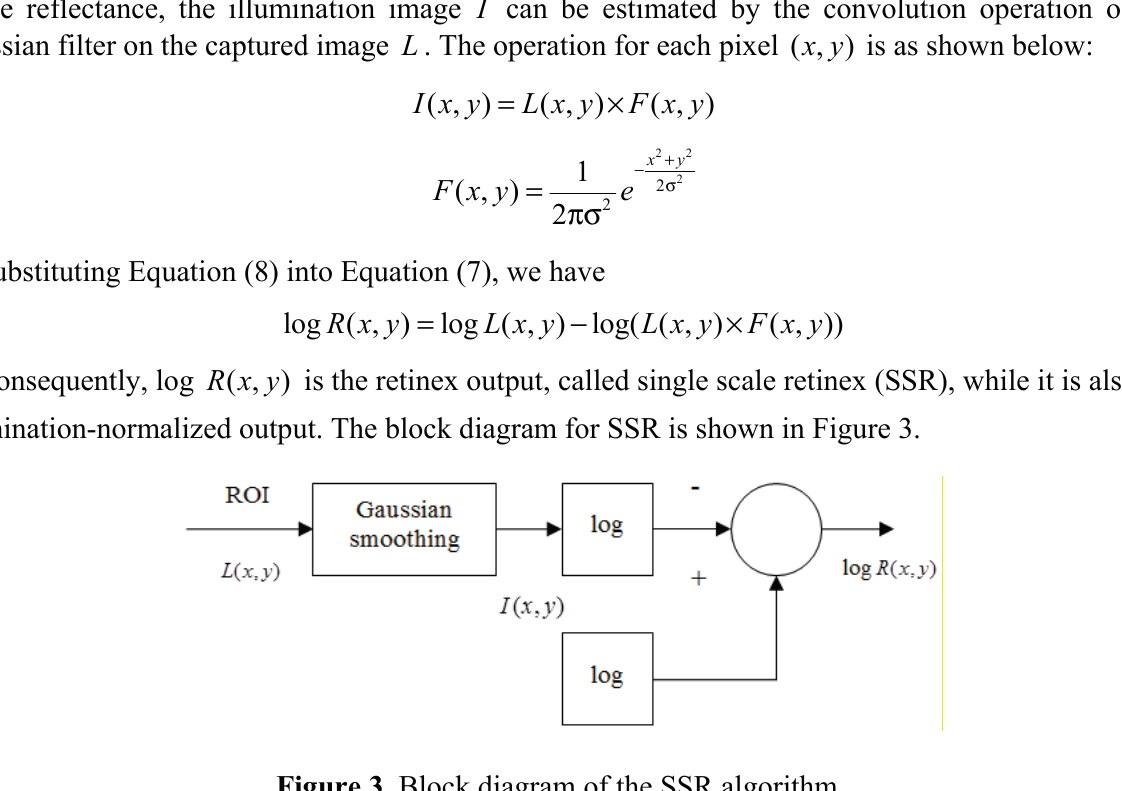
Figure 3. Block diagram of the SSR